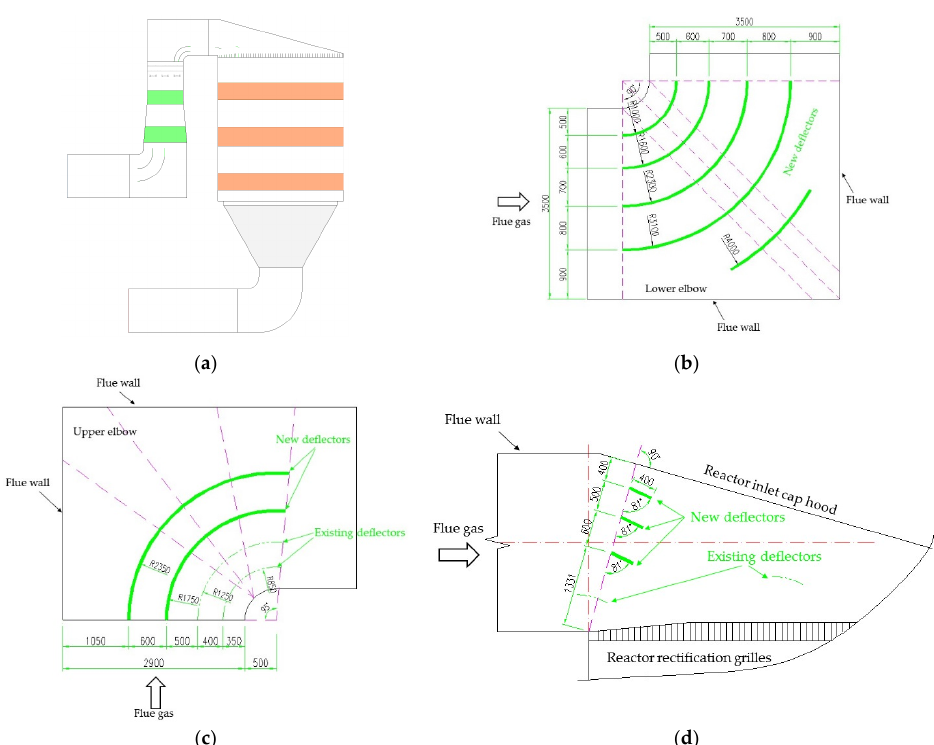
Figure 3. Deflector arrangement of the 4 schemes. For Schemes 2 to 4, this diagram shows only the adjusted sections of the deflectors, i.e., the lower elbow section, the upper elbow section, and the reactor inlet cap section, respectively: ( a ) Scheme 1: the current arrangement, which is also detailed in Figure 1; ( b ) Scheme 2; ( c ) Scheme 3; ( d ) Scheme 4.